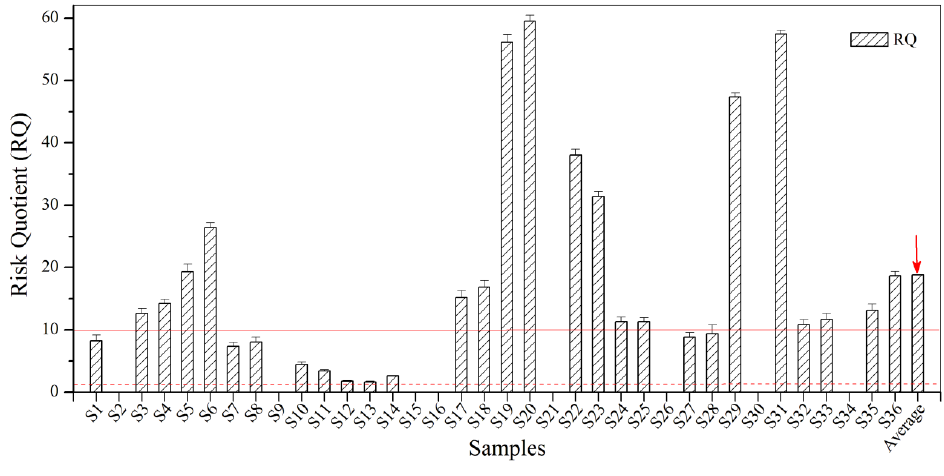
Figure 4. The RQ for BBP in the urban sewage samples.